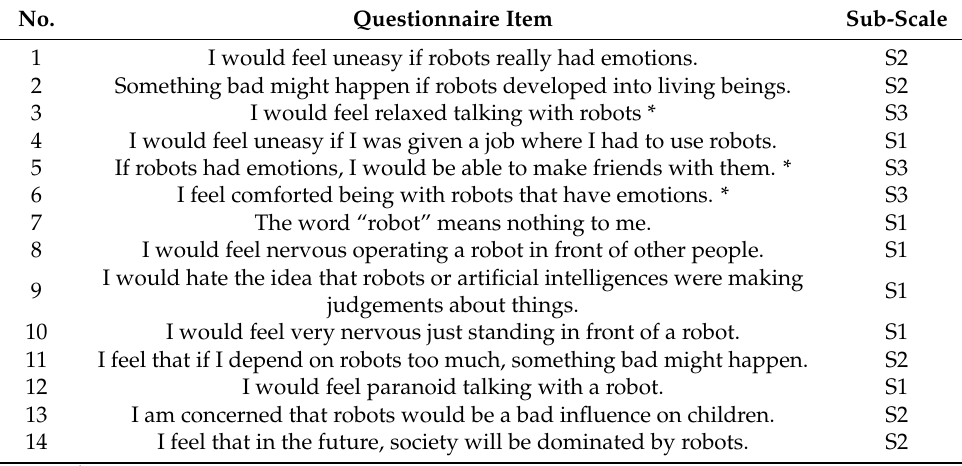
Table 2. NARS Items with